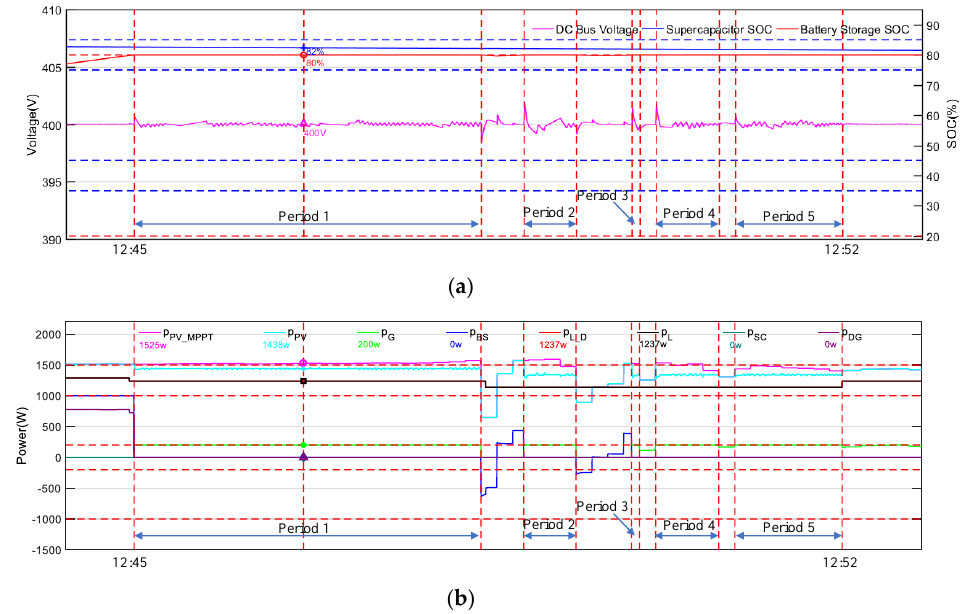
Figure 14. Curves of common DC Bus voltage and SOC of storage ( a ) and curves of power ( b ) during PV shedding.